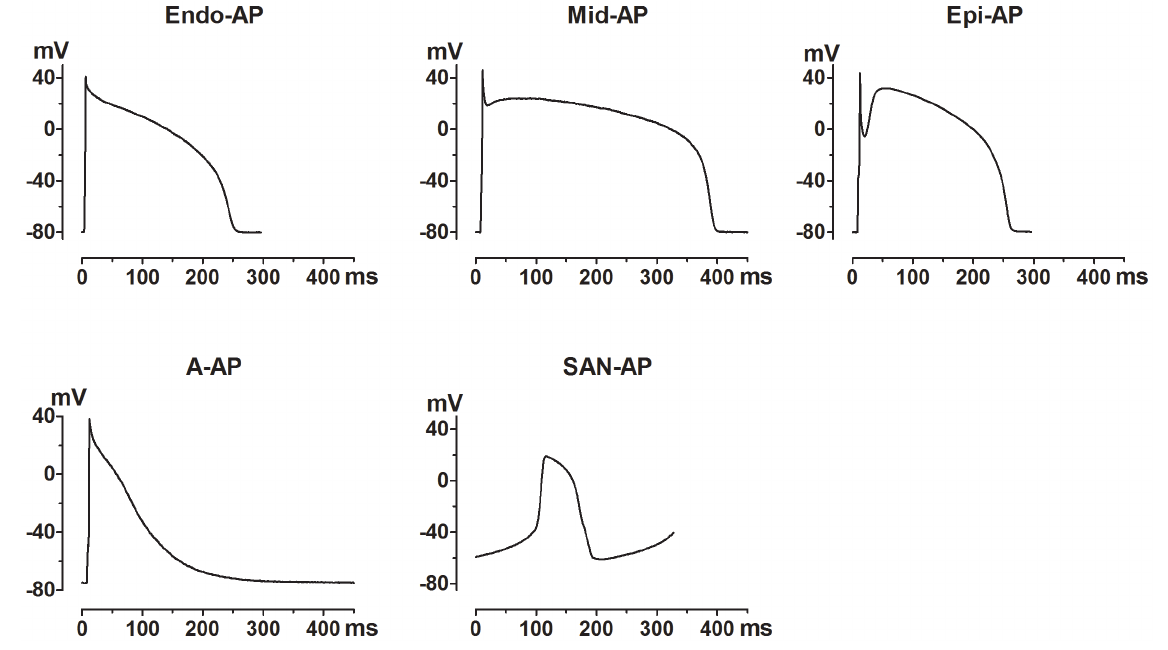
Figure 1. Action potential (AP) waveforms recorded from myocytes isolated from various regions of the canine heart. These AP waveforms were used for the AP-clamp studies of HERG K + channel function in HERG-expressing HEK293 cells. The quantitative characteristics of these APs are summarized in Table 1.